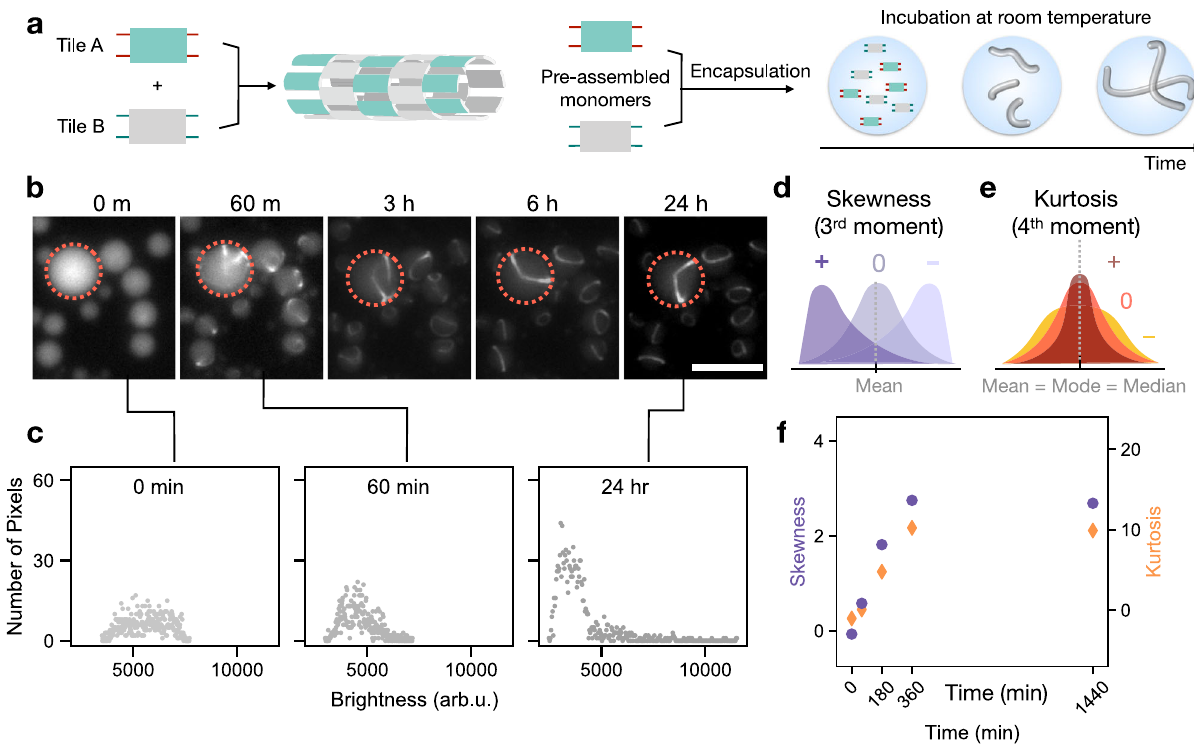
Fig. 2 Statistical analysis of droplet fl uorescence microscopy images makes it possible to track the condensation of nanotubes in a population of droplets. a The two-tile nanotube design requires both tile A and B (shown in green and gray), each with sticky-ends complementary to those of the other tile, for nucleation and polymerization of nanotubes. The tiles are annealed in vitro separately and mixed immediately before encapsulation. b Temporal sequence of representative fl uorescence microscopy images of droplets encapsulating the two-tile nanotubes at room temperature (each tile at 100 nM). c We examine the distribution of pixel brightness across a single droplet over time. As nanotubes assemble, a change in the shape of the distribution also occurs. Each plot shows the histogram of pixel brightness within the droplet of interest at the associated time. Data for this illustrative fi gure were extracted by hand using ImageJ. d Skewness is a measure of the asymmetry of the distribution of a random variable about its mean. e Kurtosis is a measure of the “ tailedness ” of the distribution of a random variable. f The skewness and kurtosis values (represented as purple dots and orange diamonds, respectively) increase as nanotubes start growing and becoming more apparent over time inside the droplet. This graph represents a single droplet only. Source data for this fi gure is provided as a source data fi le. Scale bar: 20 μ